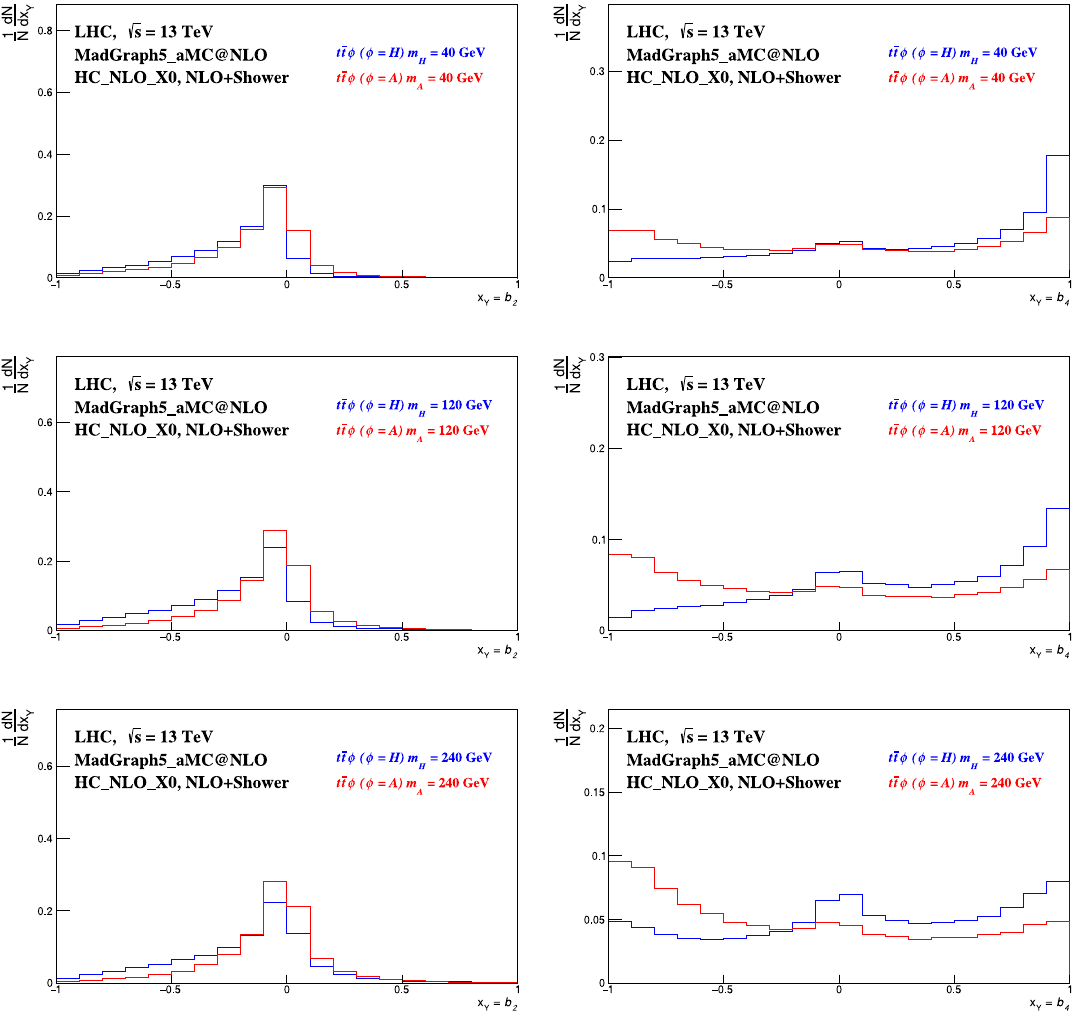
Figure 4. Full normalized distributions at NLO+Shower for the variables b 2 (left) and b 4 (right) in the LAB frame, without any selection cuts nor reconstruction, for both the pure scalar (blue line) and pure pseudoscalar (red line) signals with m (cid:30) = 40, 120 and 240 GeV. CP-even and CP-odd distributions disappears. Although this behaviour was con(cid:12)rmed for all variables, the exact mass value for which the di(cid:11)erence becomes negligible depends on the choice of variables. The maximum value of the (cid:30) boson mass for which a meaningful di(cid:11)erence between distributions exists is 400 GeV.